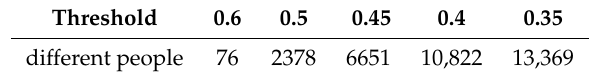
Table 4. Different people in the dataset using the Face-recognition framework similarity